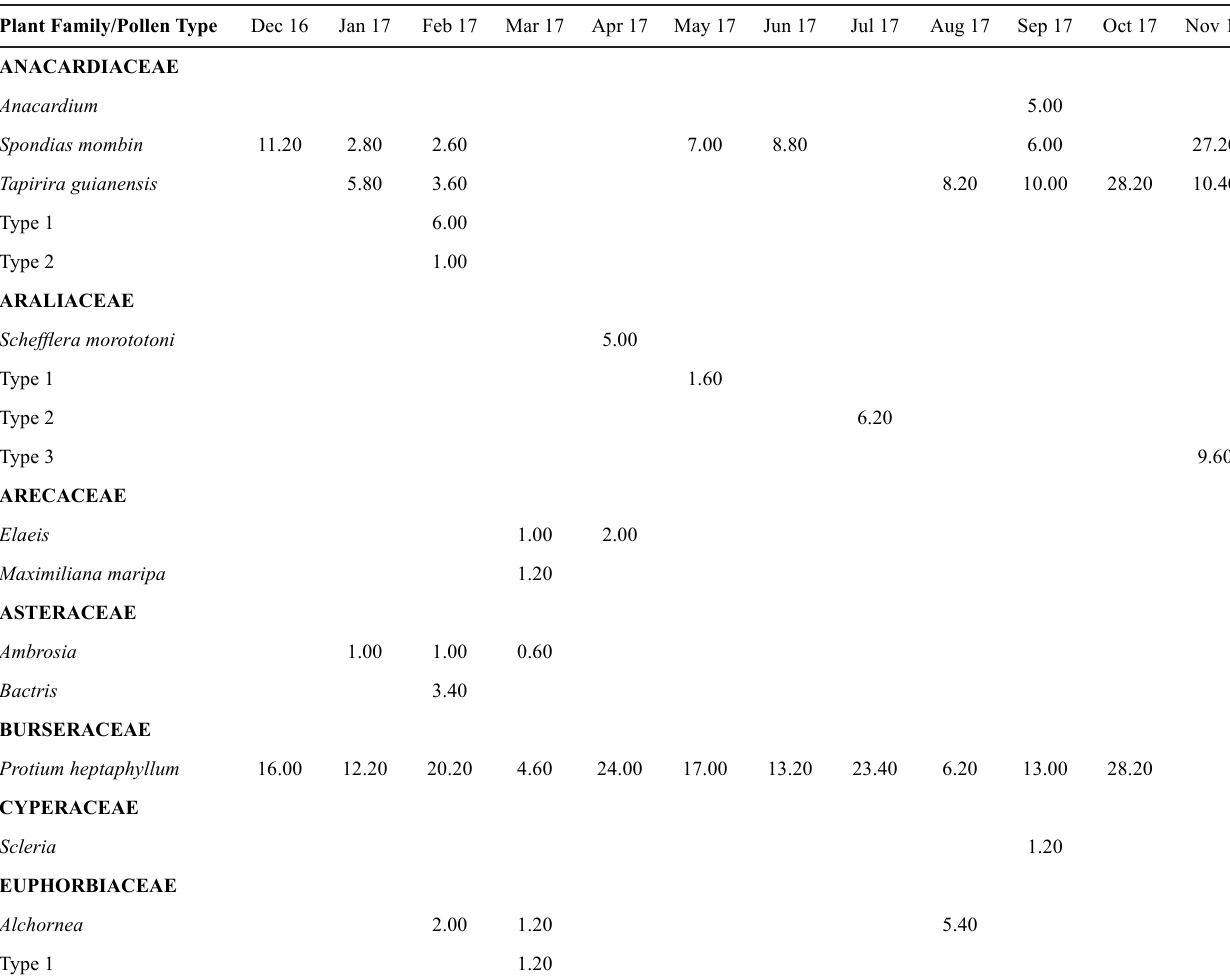
Table 1 . Frequency of pollen types found in honey samples of Melipona seminigra pernigra (Apidae: Meliponini) collected from December 2016 (Dec 16) to November 2017 (Nov 17) in the community of Suruacá, Tapajós-Arapiuns Extractive Reserve, Santarém (PA),